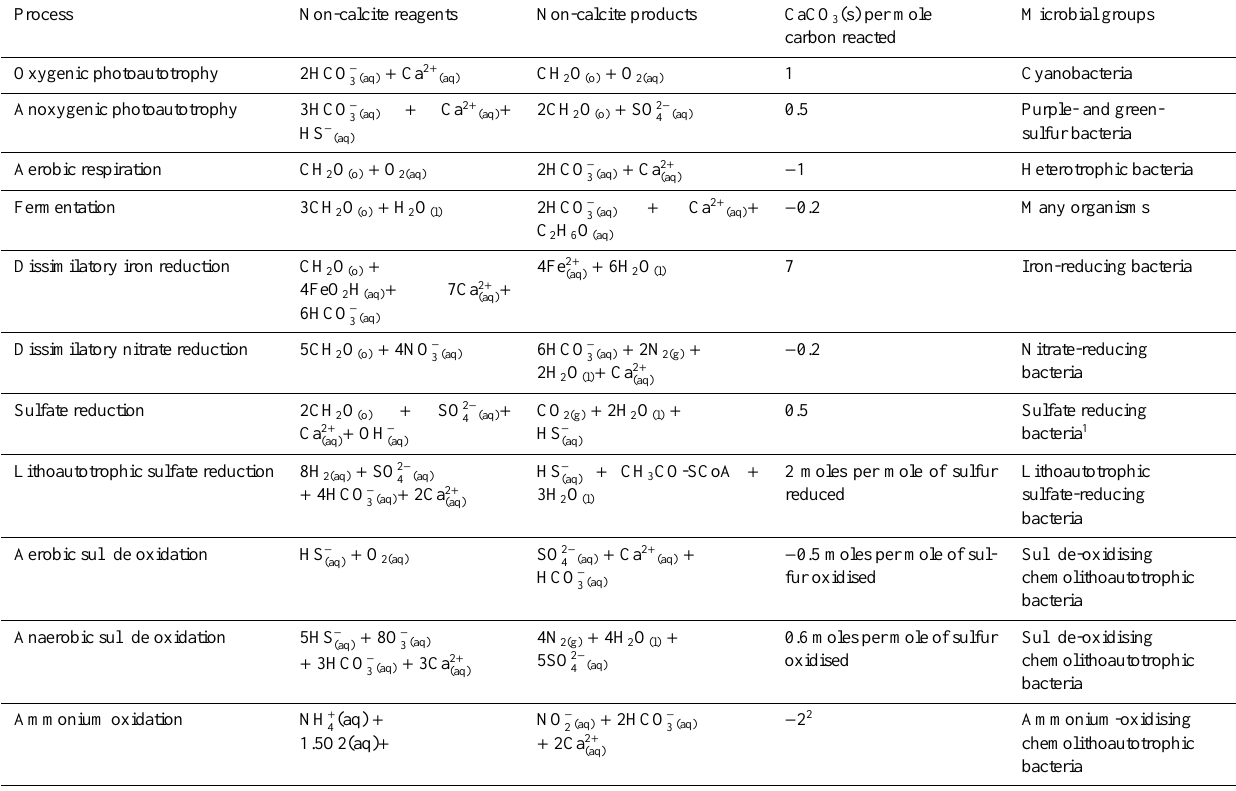
Table 1. Summary of microbial metabolic biogeochemistries, with full bicarbonate bu ff ering. Adapted from Visscher and Stolz (2005).